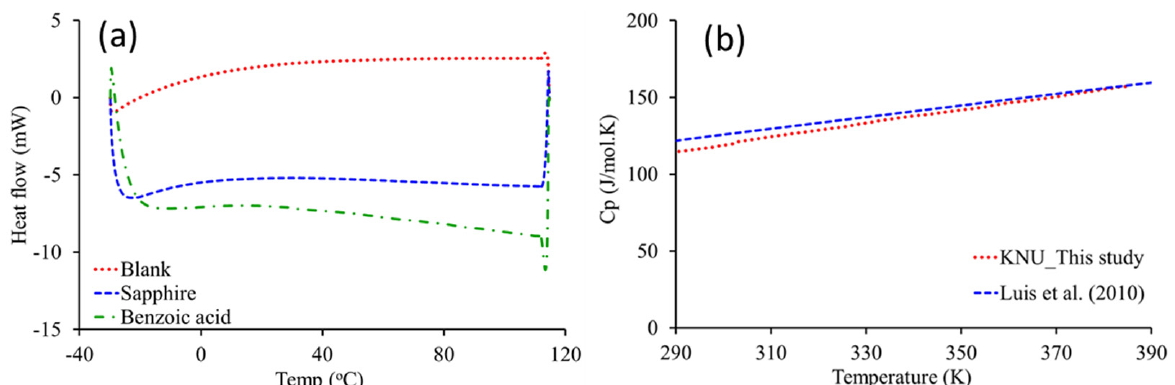
Figure 1. ( a ) Heat flow of pan, sapphire, and benzoic acid as a function of temperature. ( b ) Specific heat capacity of benzoic acid as a function of temperature. The specific heat of benzoic acid was calculated using Equation (2) and plotted as a function of temperature (Figure 1b). The heat capacity of benzoic acid at room tem- perature (298.15 K) was 118.1 J mol − 1 K − 1 , which is consistent with the reported value abovementioned method and summarized in Table 1. In most cases, the specific capacity increased by less than 1% with a 1 ◦ C change in temperature. This indicates that the specific heat capacity of SOA species varies with temperature. This temperature-dependence of specific heat capacity has been reported with Equation (4). Herein, for SOA species, the coefficients in Equation (4) were estimated using linear regression and are listed in Table 1. Table 1. Heat capacities of biogenic and anthropogenic SOA species.